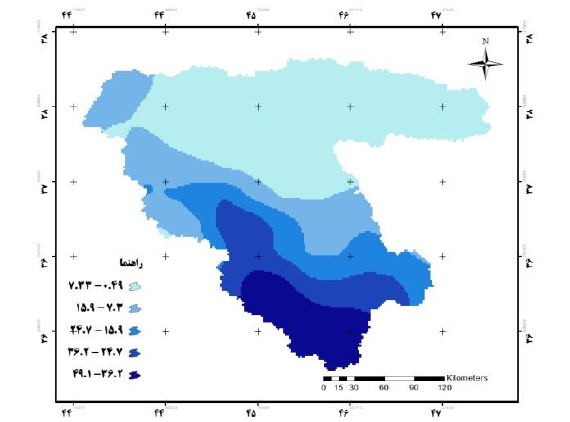
Figure 17: Interpolation of TRMM precipitation data over the catchment basin of Urmia lake (April 20 th )